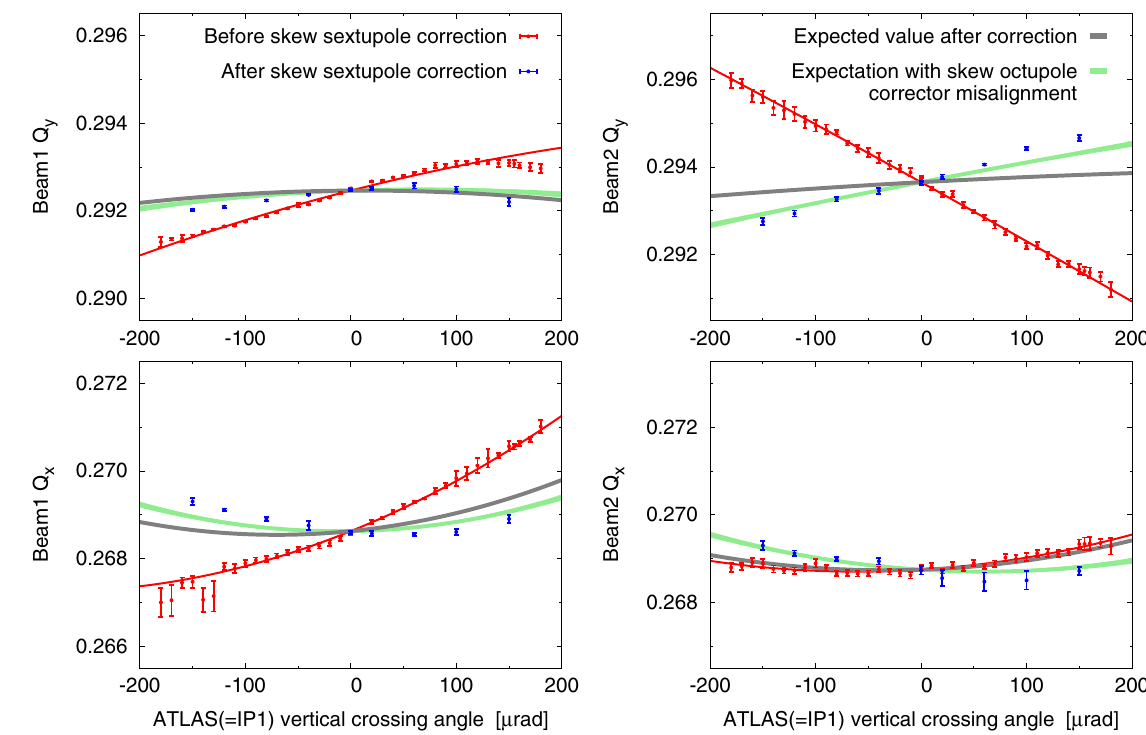
FIG. 20. Tune shift of LHC Beam 1 (left) and LHC Beam 2 (right) as a function of vertical crossing angle in IR1 (ATLAS). Red data shows the tune shift measured after application of normal octupole corrections, but before correction of normal/skew sextupole or skew octupole. The fit to the measured data is also shown in red. Blue data corresponds to the tune shift measured after application of normal/ skew sextupole, and skew octupole corrections. The gray line indicates the expected variation of tune after correction, based upon the red fit and expected performance of the skew sextupole correction. The green line represents the expected variation after correction, where the skew octupole corrector misalignment inferred from Q -shift during its application has been incorporated as a source of linear tune variation.